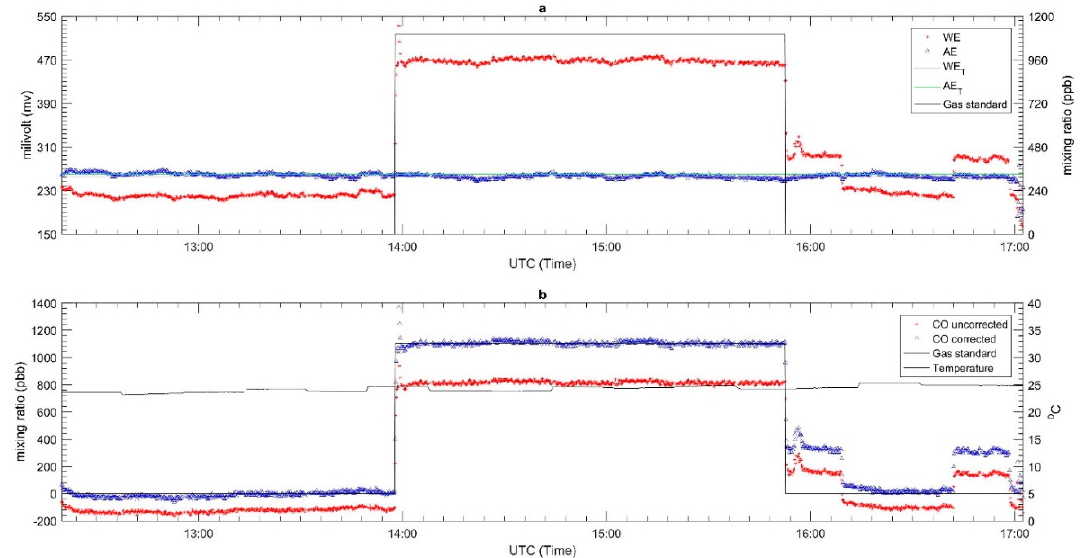
Figure 8. The laboratory calibration of CO-A4 EC sensor ( a ) the electrode signal along with the gas standard and ( b ) The signal converted to mixing ratio and temperature.